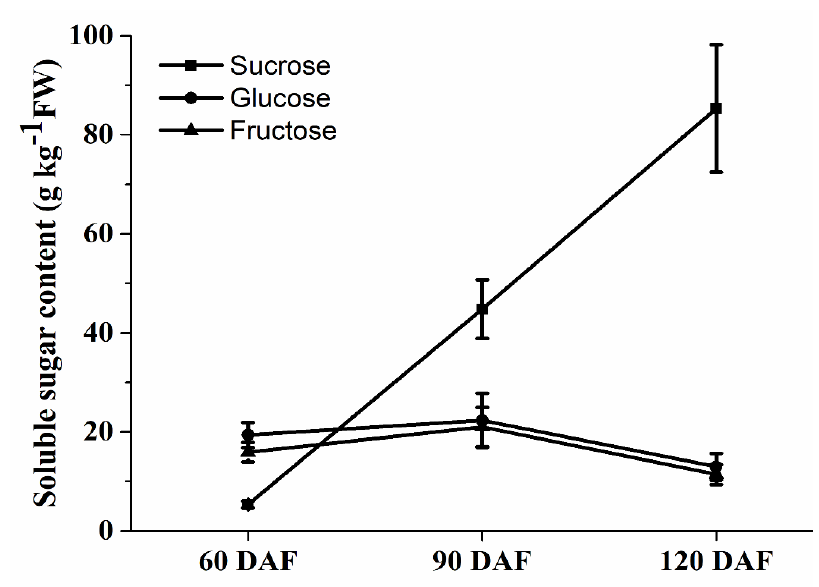
Figure 1. The content of sucrose, glucose, and fructose during longan fruit developmental stages. Values presented as mean ± standard error (SE) ( n = 3).